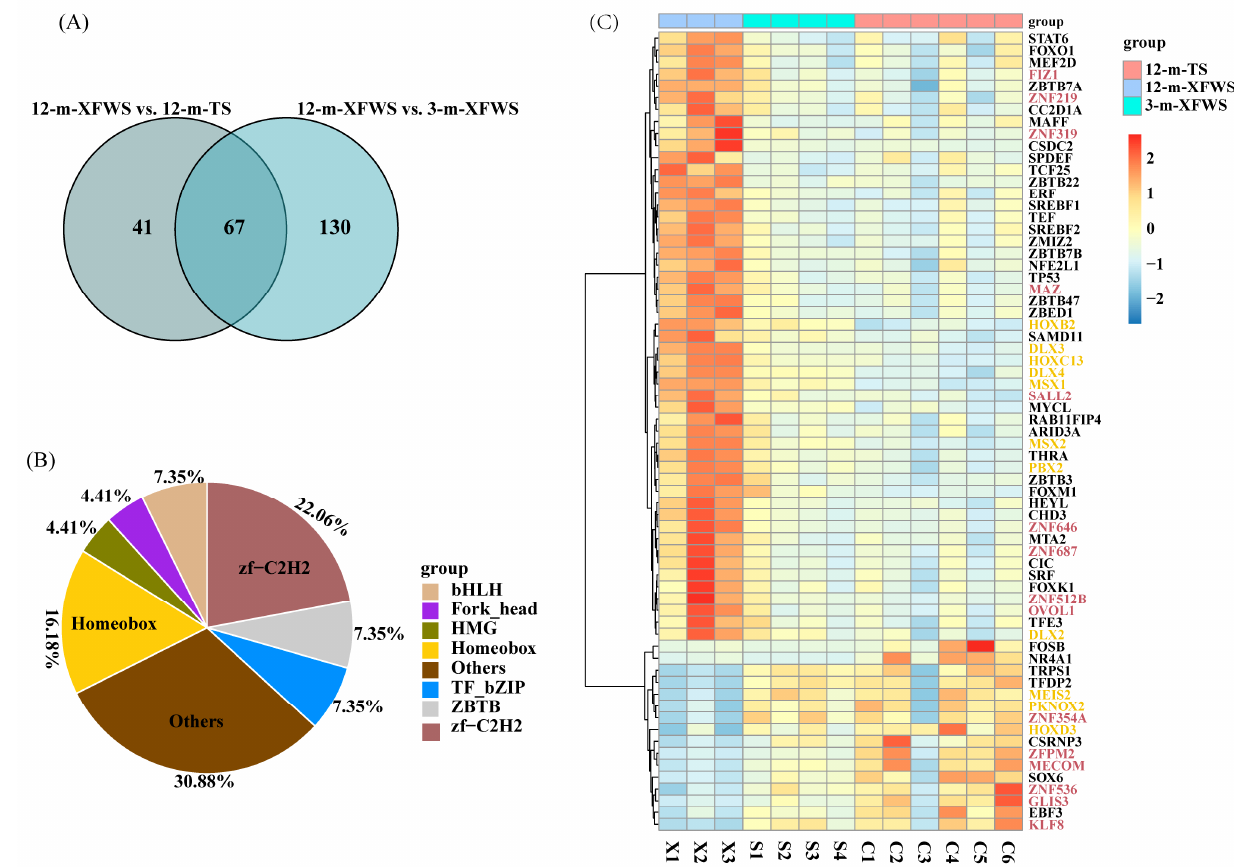
Figure 5. Annotation of transcription factors of specific DEGs. ( A ) A Venn diagram of overlapped TFs in different breeds and during different periods (TFs, transcription factors). ( B ) The family classification of TFs. ( C ) TPM value of the clustering of overlapped TF expression level in skin tissue. (Genes marked deep pink represent members of the zf-C2H2 TF family; genes marked yellow represent members of the homeobox TF family.)